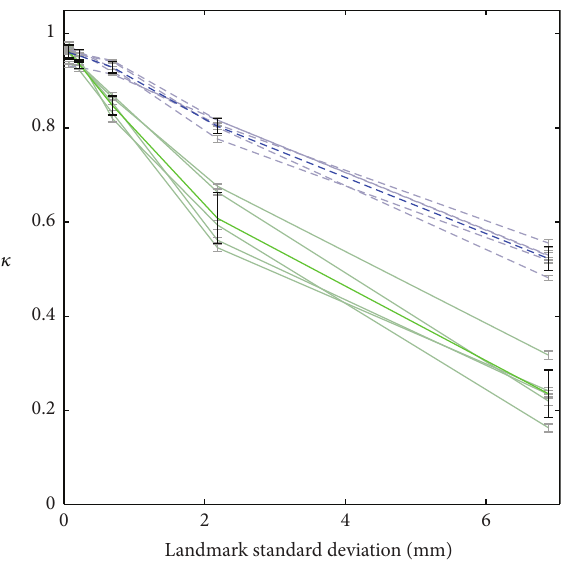
Figure 12: Kappa scores are shown for the 5 simulated cases (desaturated) and mean and standard deviation (saturated), as a function of landmark noise. Green/bottom: standard landmark matching; blue/top: GDAS landmark